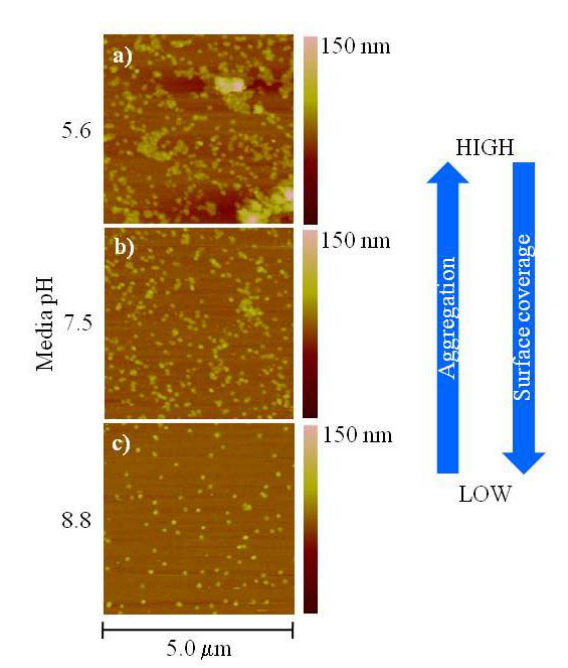
Figure 3. Atomic force microscopy (AFM) topographical images of T4 nanoparticles deposited on aminosilanized glass. In each case a 1:50 dilution from the stock solution was made in 10 mM Tris-HCl at pH a) 5.6, b) 7.5 and c)